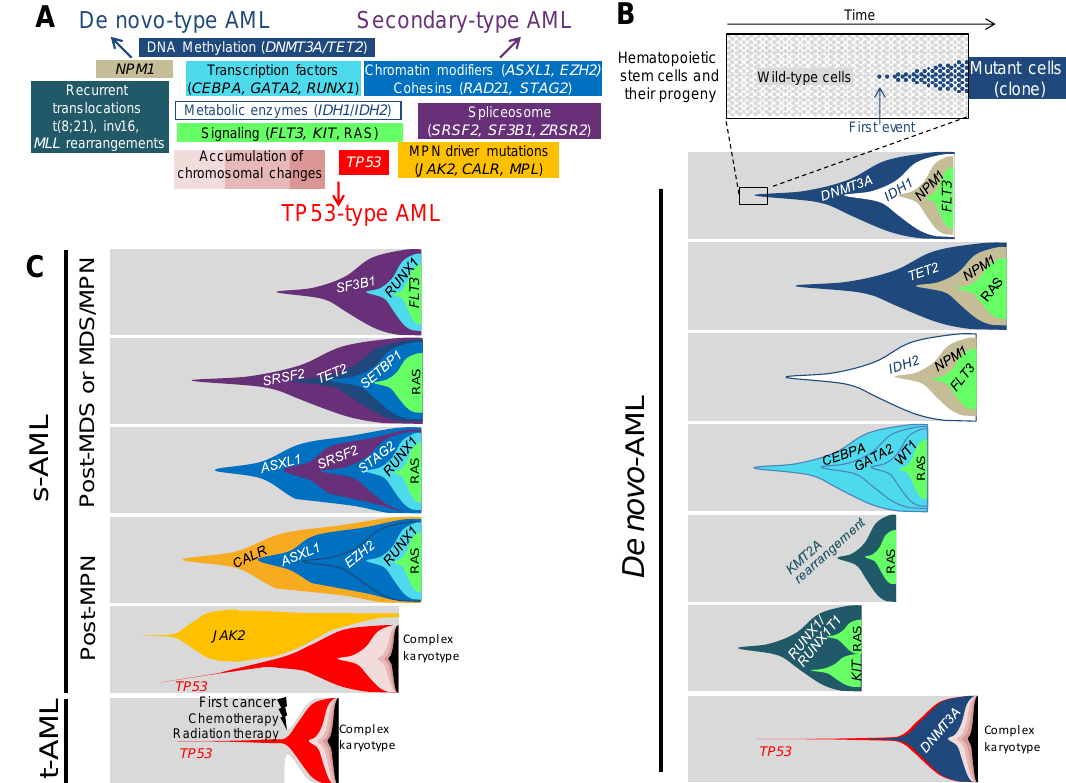
Figure 1. Associations and orders of acquired lesions in de novo , secondary, and therapy-related AMLs. ( A ) A schematic view of the multiple lesions underlying leukemogenesis and AML ontology, according to the classification in de-novo -type, secondary-type, and TP53-type AMLs—central lesions are shared by all types of AMLs, whereas outlying ones are either specific to or enriched in the type of AML indicated by the nearest arrow. Only the most frequent lesions are indicated in each category. ( B ) Fish diagrams of representative (but not exhaustive) clonal AML hierarchies in de novo AMLs. Grey areas show normal hematopoietic stem cells and their progeny. The onset of a clone is achieved through the acquisition of a genetic lesion (first lesion) and the subsequent expansion of mutant cells (colored cells and areas), as indicated in the top panel. Subsequent events will shape the clones with time and lead to AML. Lesions are color-coded, as indicated in panel A. ( C ) Fish diagrams showing representative (but not exhaustive) clonal AML hierarchies in secondary AMLs (s-AML) and therapy-related AMLs (t-AML), as in B.